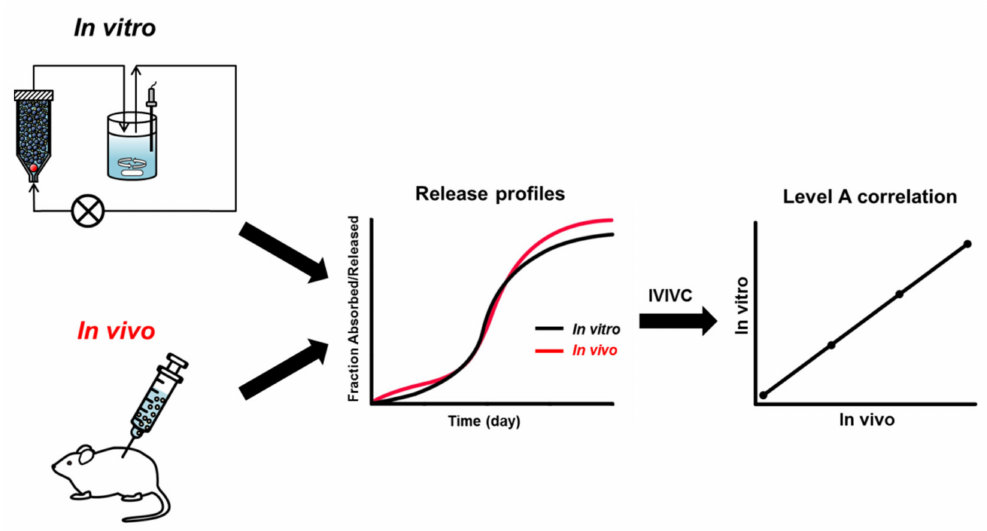
Figure 4. Schematic representation of Level A correlation between in vitro release profiles and in vivo release profiles of particulate